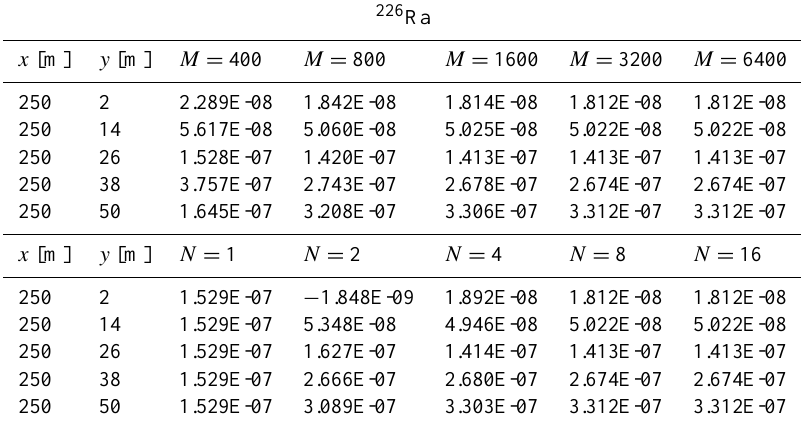
Table 5. Solution convergence of each species concentration at transect of exit boundary ( x = 250m) for four-species radionuclide trans- port problem considering simulated domain of L = 250m, W = 100m subject to Bateman-type sources located at 40m ≤ y ≤ 60m for t = 1000years ( M = number of terms summed for inverse generalized integral transform and N = number of terms summed for inverse finite Fourier cosine transform). When we investigate the required M for inverse generalized integral transform, N = 16 for the finite Fourier cosine transform inverse are used. When we investigate the required N for inverse finite Fourier cosine transform, M = 6400 for the gener- alized transform inverse are